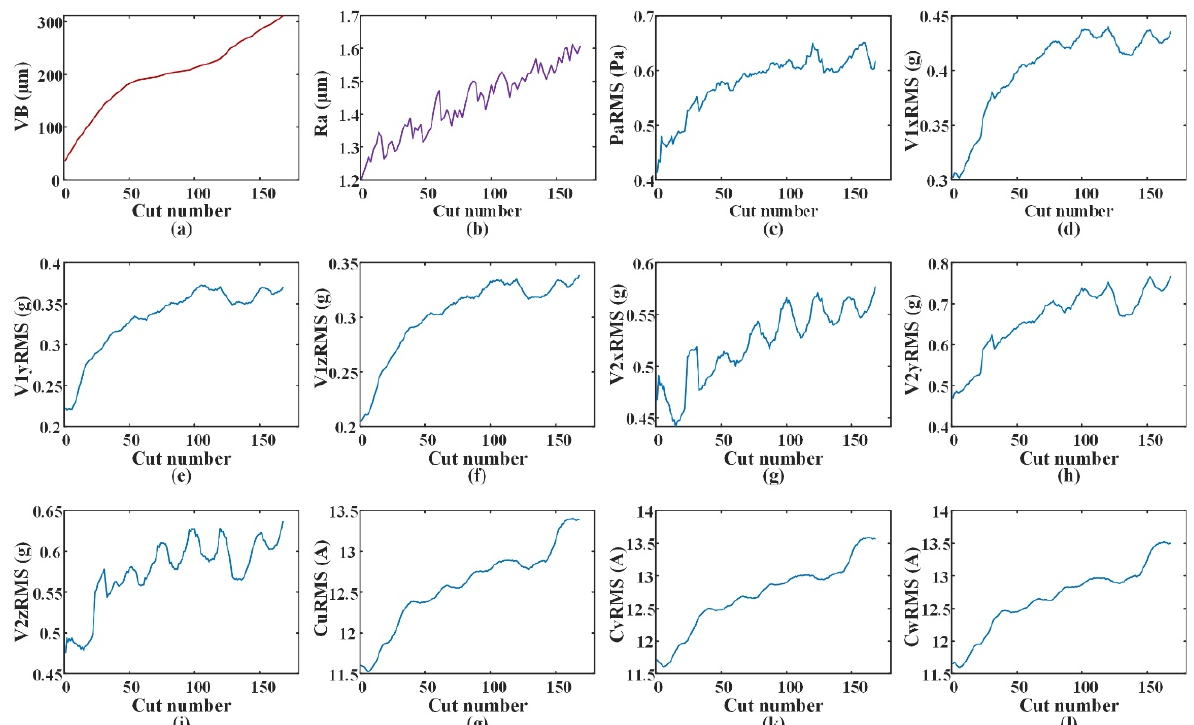
Figure 8. Data preparation for surface roughness prediction: ( a ) Tool wear prediction process in the target domain; ( b ) data generation process for roughness prediction integrating tool wear in the target domain.